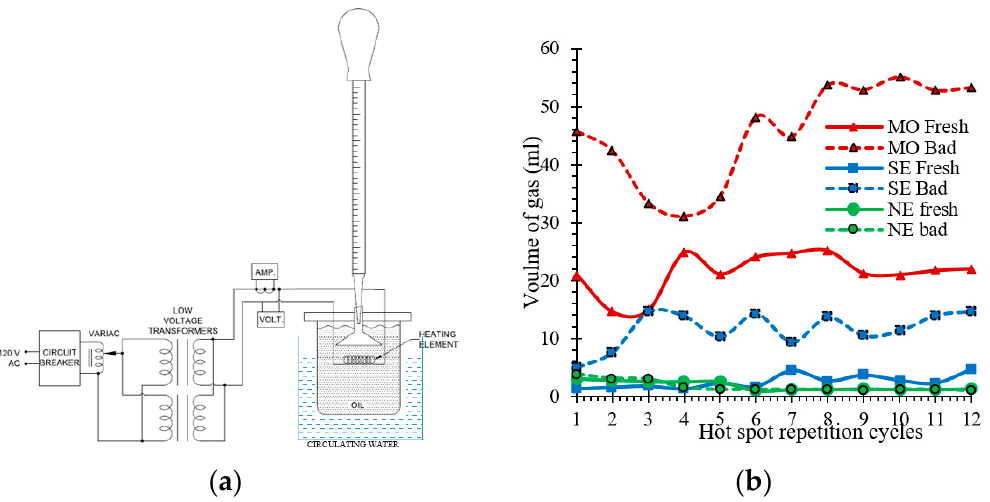
Figure 3. Experimental of the hotspot fault in various dielectric fluids; ( a ) test set up used for hotspot; ( b ) gassing tendency under hotspot condition .